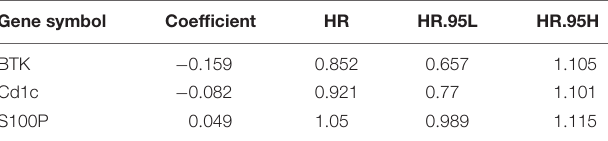
TABLE 1 | Top three prognosis-associated genes identified by lasso regression